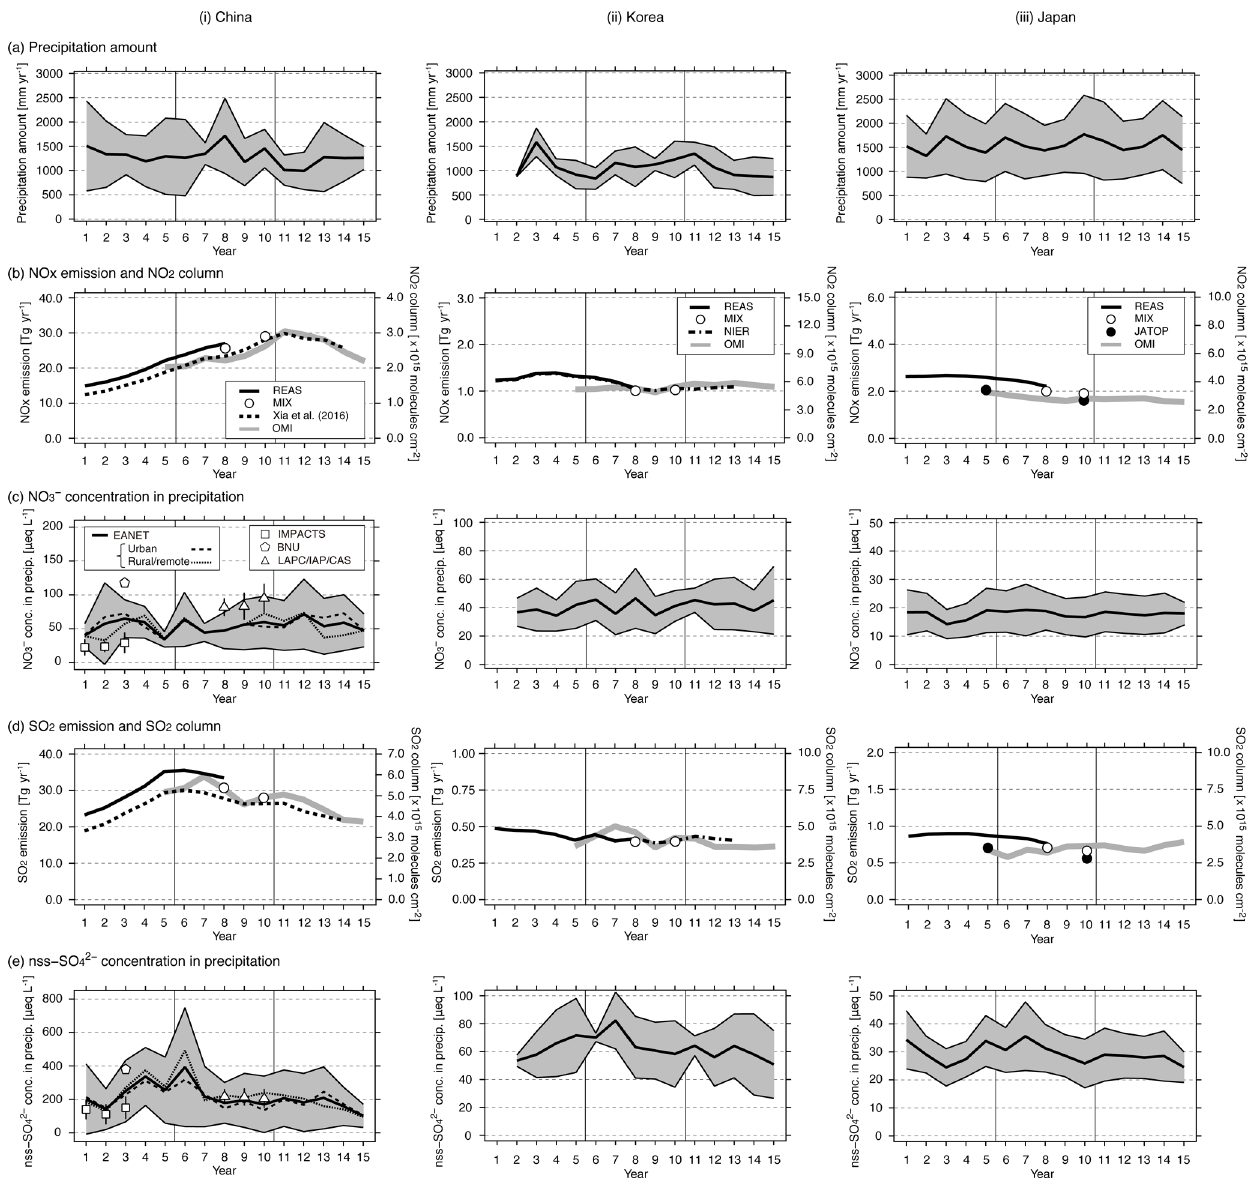
Figure 2. Long-term temporal variation in (a) precipitation, (b) NO x emission with the NO 2 column, (c) NO − concentration in precipitation, 3 (d) SO 2 emission with the SO 2 column, and (e) nss-SO 2 − concentration in precipitation during 2001–2015 over (i) China, (ii) Korea, and 4 (iii) Japan. Mean and 1 standard deviation across EANET observation sites (JMA and CRIEPI sites are also included in Japan) are indicated by the thick lines and shaded areas, respectively, in (a, c, e) . For China, EANET observation sites are denoted with dashed lines for urban sites and dotted lines for rural and remote sites, and observation campaign data are indicated by marks corresponding to marks on Fig. 1. The numbers at the bottom indicate the number of years after 2000 (e.g., 5 indicates 2005 and 10 indicates